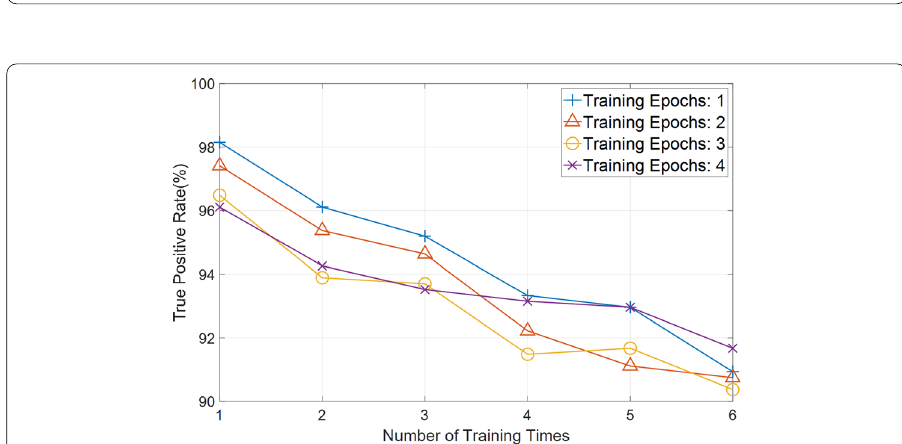
Fig. 17 Relationship between accuracy and training times (True Positive Rate). The relationship between accuracy and the number of training times for legitimate devices is depicted in this figure with different training